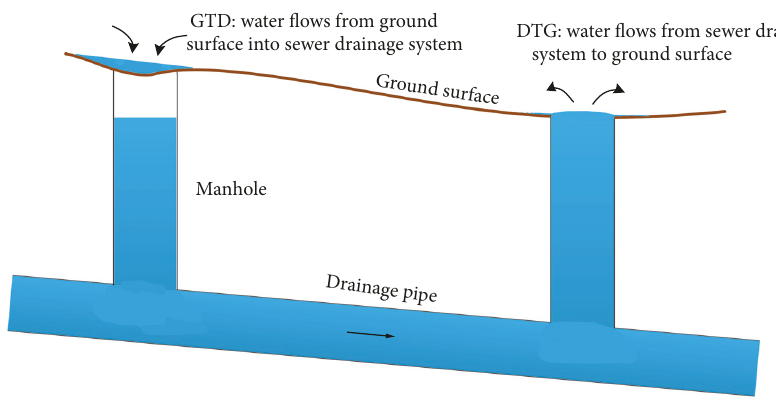
Figure 2: Schematic illustration of flow exchange between surface and subsurface systems.